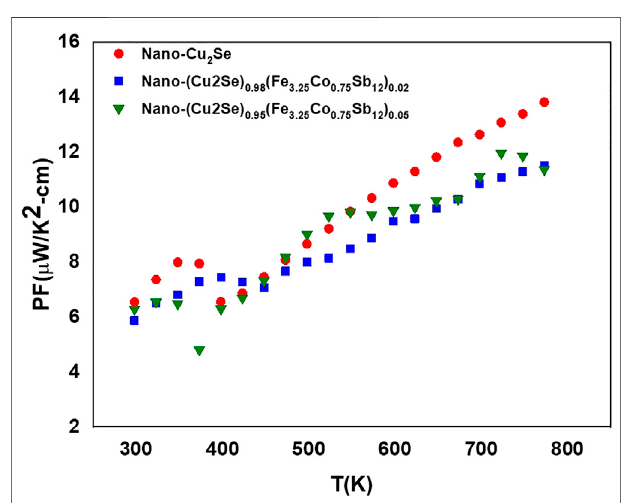
FIGURE 12 | Power factor (PF) function of temperature for nano-Cu (nano-Cu 2 Se) 0.95 (nano-FeCoSb) 0.05 and (nano-Cu 2 Se) 0.98 (nano-FeCoSb) 0.02 samples.